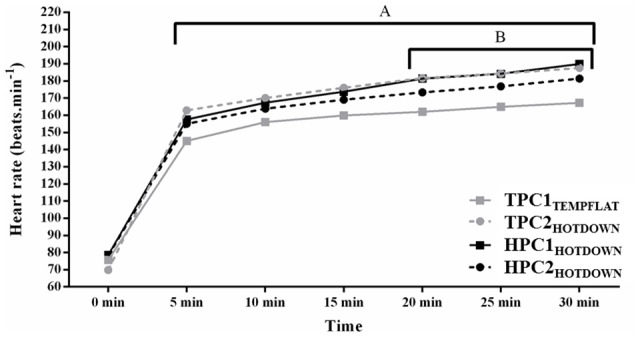
Heart rate (HR) at 0–30 min of exercise. A, increased (p < 0.010) during TPC2HOTDOWN compared to TPC1TEMPFLAT at 5–30 min. B, increased (p < 0.050) during HPC1HOTDOWN increased compared to TPC1TEMPFLAT at 20–30 min. Mean data presented. Error bars omitted to maintain clarity.